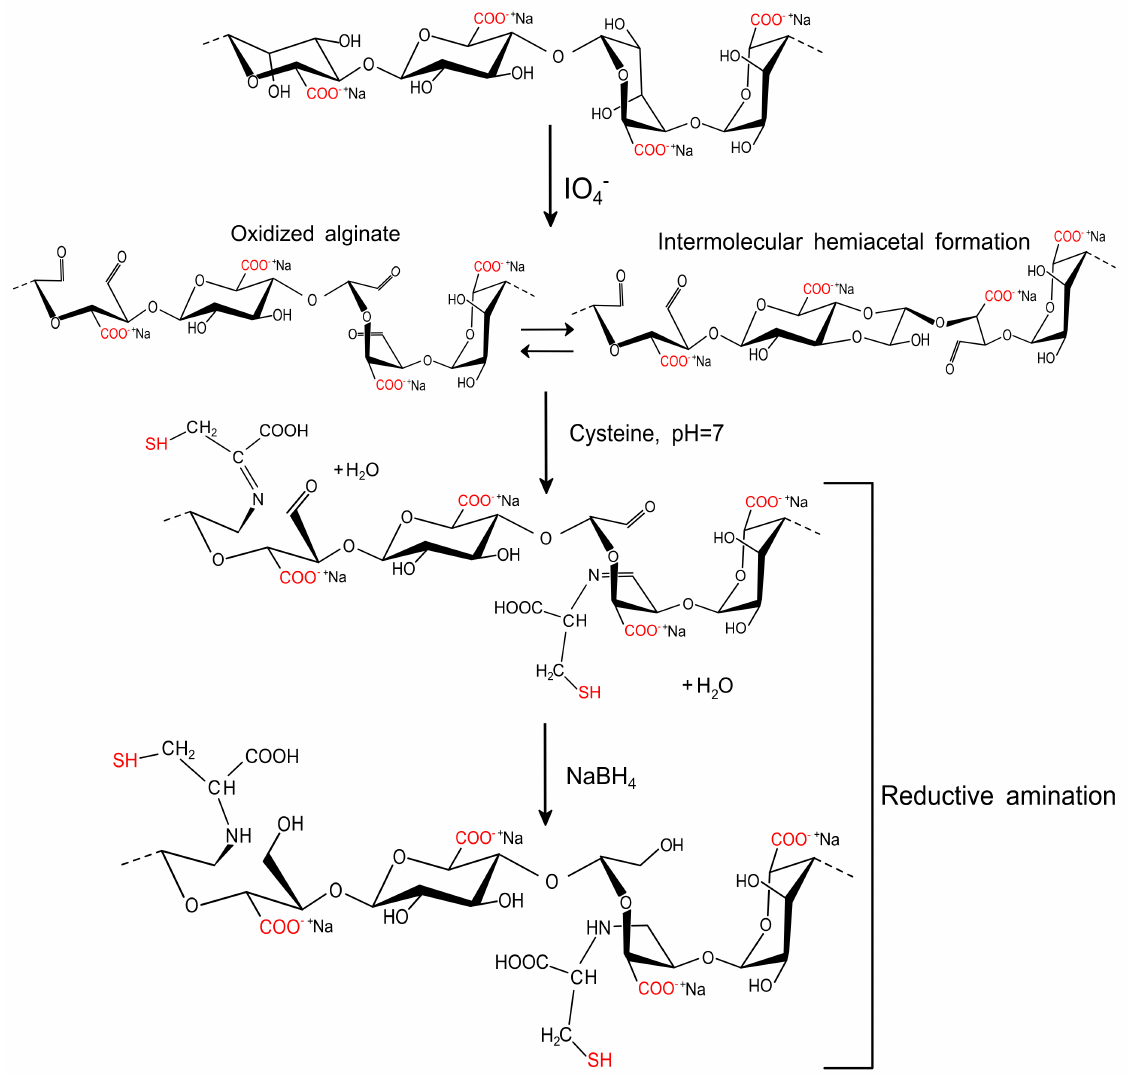
Figure 2. Proposed reaction for the functionalization of sodium alginate with cysteine employed by oxidation and reductive